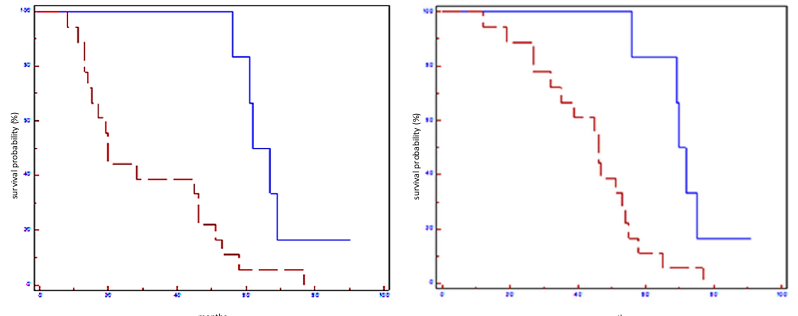
Figure 5. Prognostic impact of miRNA signature on EFS (on the left) and OS (on the right) in all